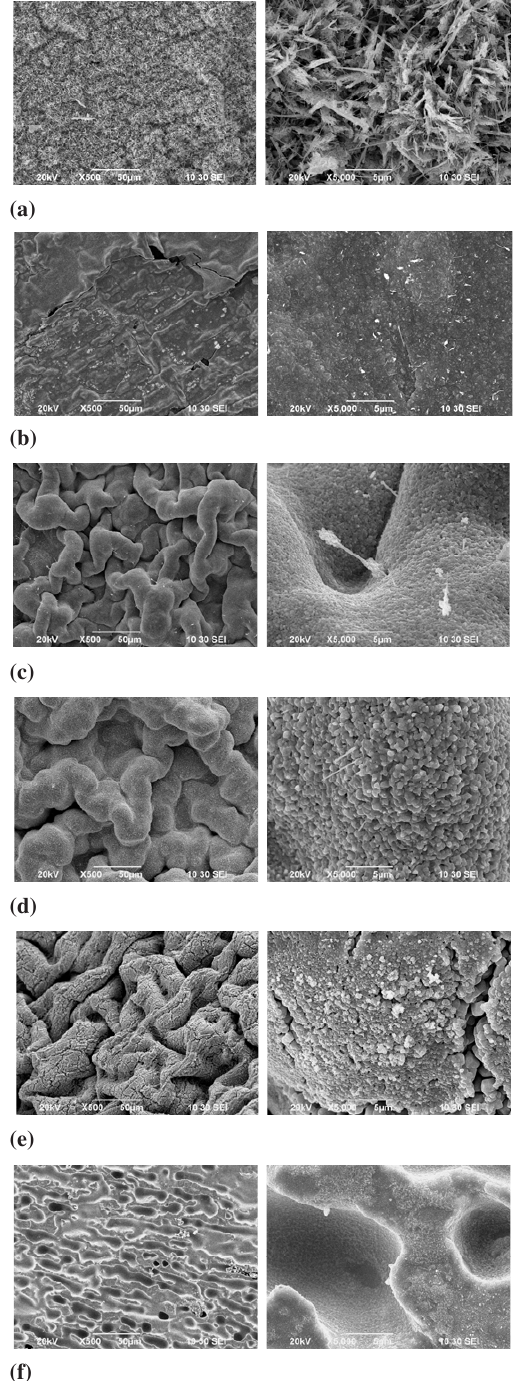
Figure 2. Morphologies of Cu-38at.%Zn specimens oxi- dized at the temperatures of (a) 773 K, showing nanostruc- ture on the scale; (b) 873K, showing less convoluted oxide scale; (c) and (d) 973 K and 1073 K, respectively, show- ing heavily convoluted oxide scales; (e) 1123 K, showing cracks on heavily convoluted oxide scale and (f) 1123 K, showing substrate after the spallation of oxide scale; (left: low magnification and right: high magnification).